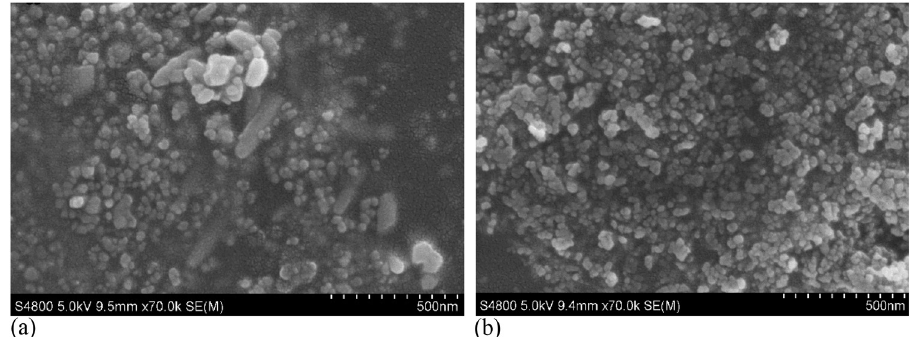
Figure 3: SEM patterns of Ag/ZnO and Ce/Ag/ZnO: ( a ) Ag/ZnO, ( b )